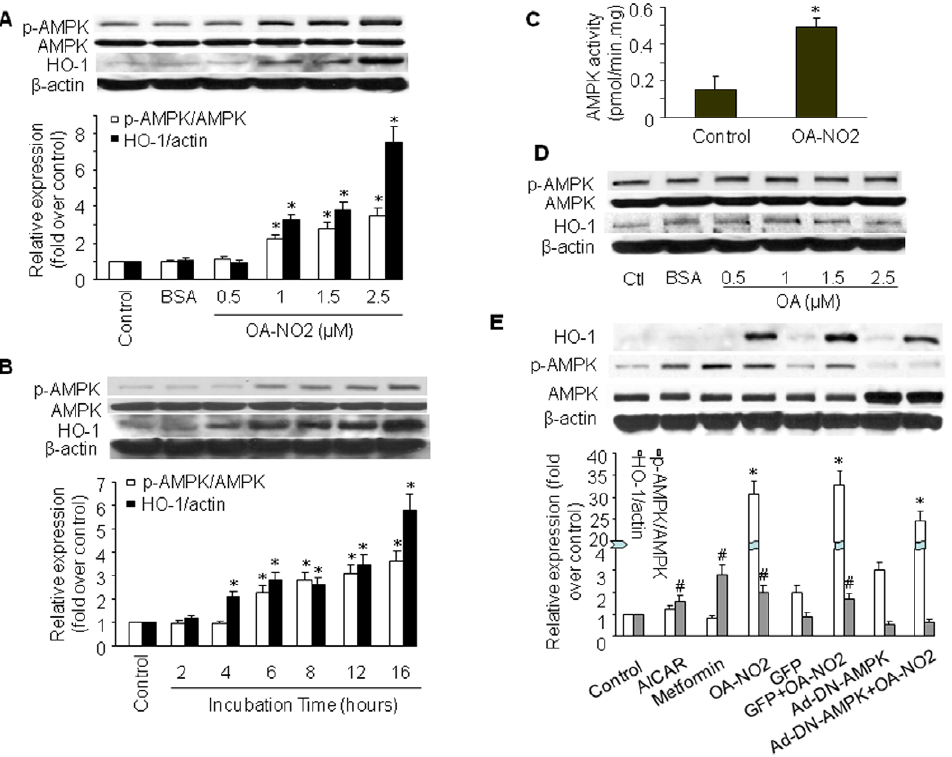
Figure 1. Induction of HO-1 protein and AMPK activation by OA-NO 2 . A ) BAECs were incubated with OA-NO 2 at the indicated concentrations or with BSA (vehicle) for 16 h, and western blot analysis was performed as described in Materials and Methods to detect HO-1 protein expression and AMPK phosphorylation at Thr172. The blot is representative of those obtained from three separate experiments. Corresponding densitometric analyses of phosphorylated AMPK and ACC are shown. * p , 0.05 vs. control. B ) BAECs were incubated with 2.5 m M OA-NO 2 for the indicated times, and western blotting was performed as above. The blot is representative of three blots obtained from three separate experiments. * p , 0.05 vs. corresponding control. C ) Confluent BAECs were exposed to vehicle or OA-NO2 (2.5 m M) for 16 h. AMPK a was immunoprecipitated from cell lysates (1 mg) with a specific antibody. AMPK activity was assayed by 32 P-ATP incorporation into the SAMS peptide. * p , 0.05 vs. control. D ) BAECs were incubated with the indicated concentrations of OA for 16 h. Western blotting was performed as described in Materials and Methods. E ) BAECs were infected with Ad-DN-AMPK (MOI=50) or Ad-GFP (control). Infected and non-infected cells were treated with 2.5 m M OA-NO 2 for 16 h. AICAR and metformin were used as positive controls. The blot is representative of three blots obtained from three separate